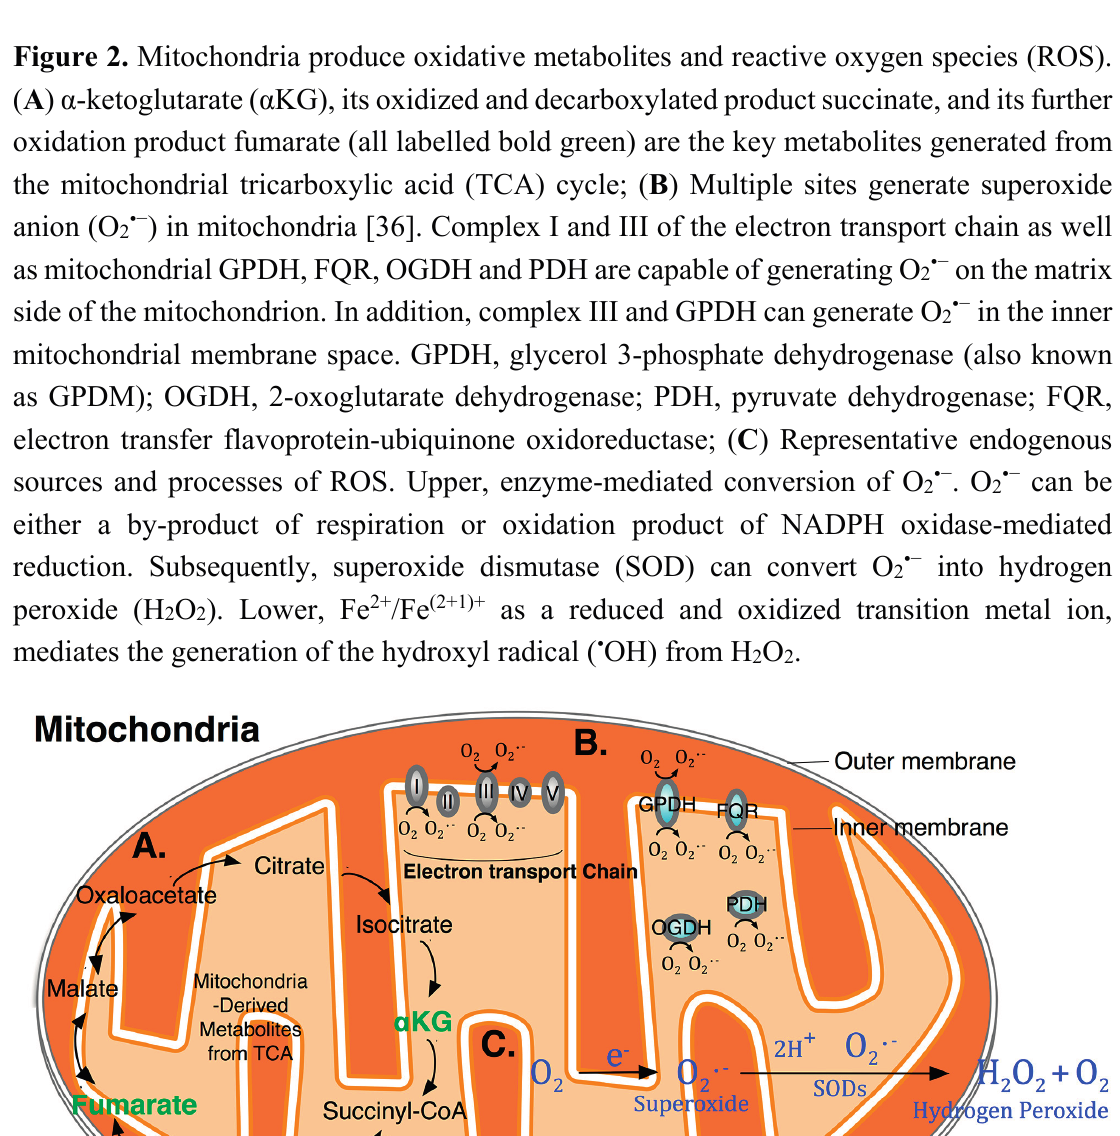
Figure 2. Mitochondria produce oxidative metabolites and reactive oxygen species (ROS). ( A ) α -ketoglutarate ( α KG), its oxidized and decarboxylated product succinate, and its further oxidation product fumarate (all labelled bold green) are the key metabolites generated from the mitochondrial tricarboxylic acid (TCA) cycle; ( B ) Multiple sites generate